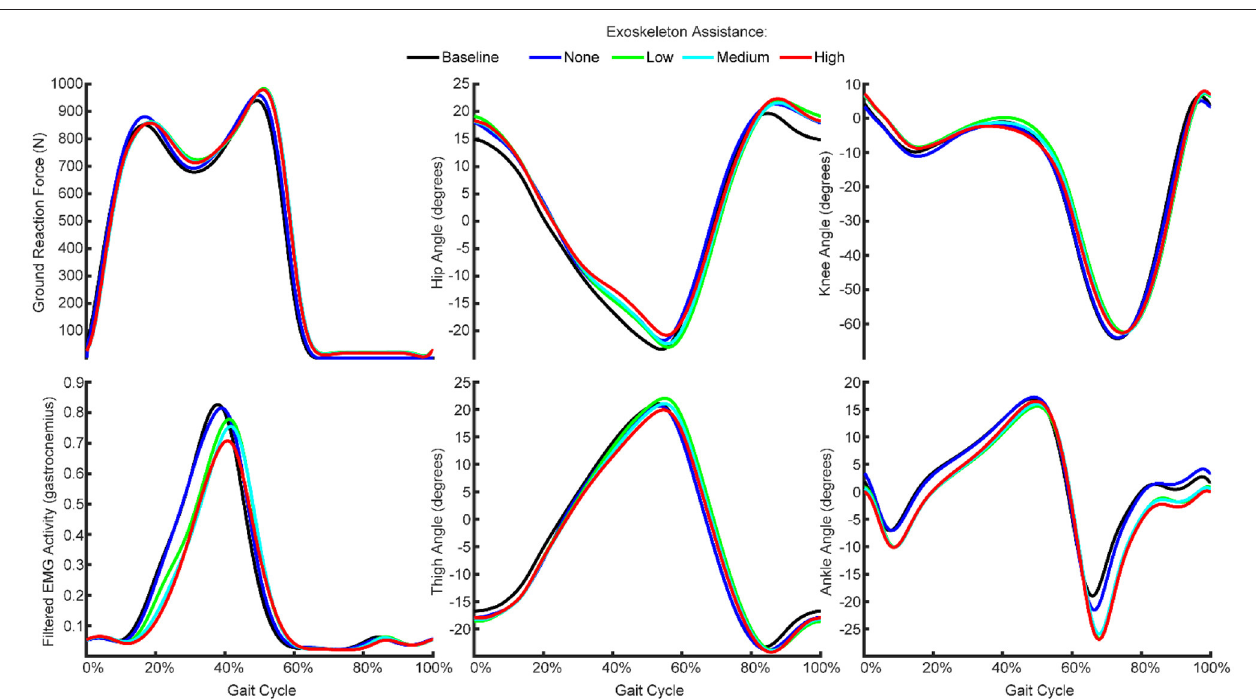
FIGURE 2 | Mean ground reaction force, kinematics and EMG features across all gait cycles from one participant recorded during the baseline condition and with exoskeleton assistance set to none, low, medium, or high. The participants walked at a fixed speed with varying levels of exoskeleton assistance, such that kinematics and gait were generally consistent while EMG activity generally decreased with increasing exoskeleton assistance.